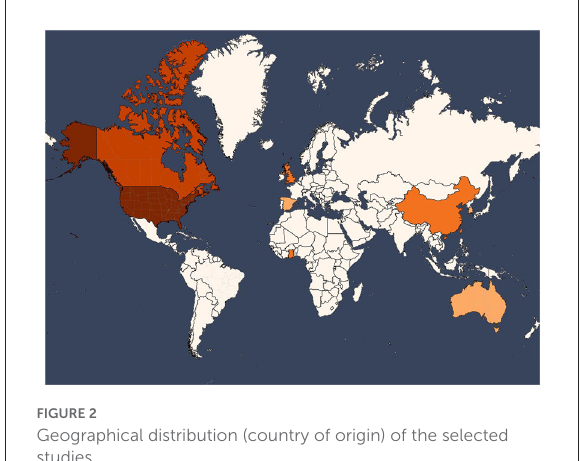
FIGURE2 Geographical distribution (country of origin) of the selected studies.